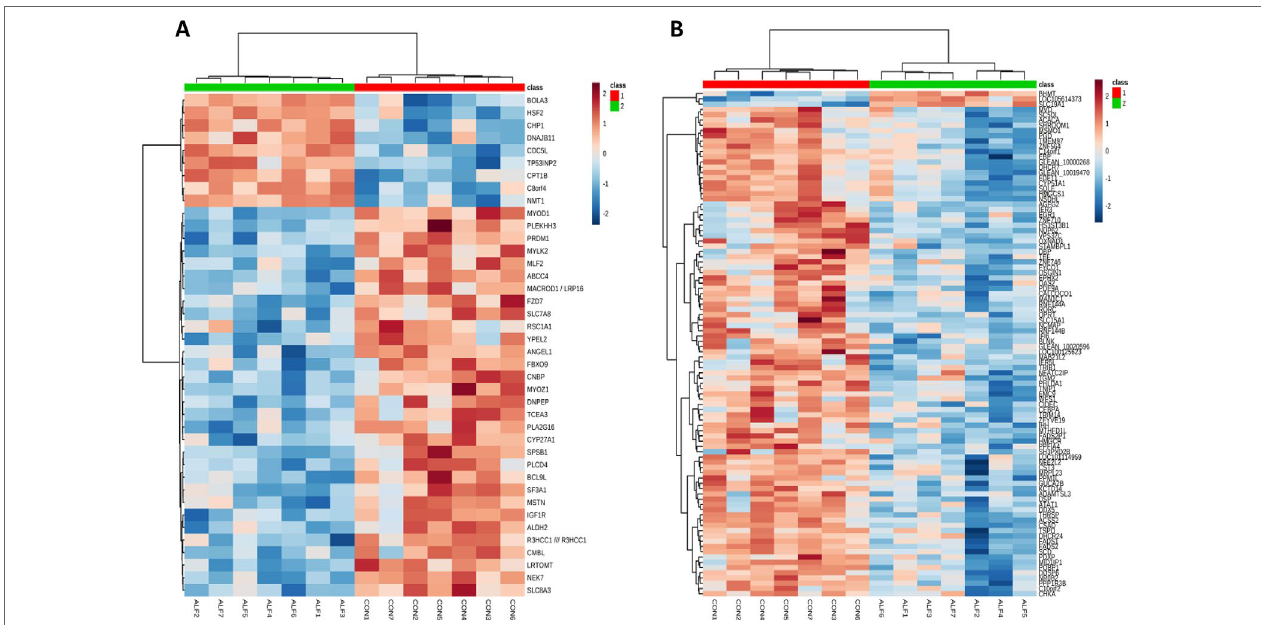
FiGURE 3 | Hierarchical clustering analysis of significant gene expression in the (A) LT muscle and (B) liver of CON lambs (1) and ALF lambs (2). Cells are colored based on the measured signal intensity. Dark brown represents high gene expression levels, blue indicates low signal intensity, and gray cells represent the intermediate level.